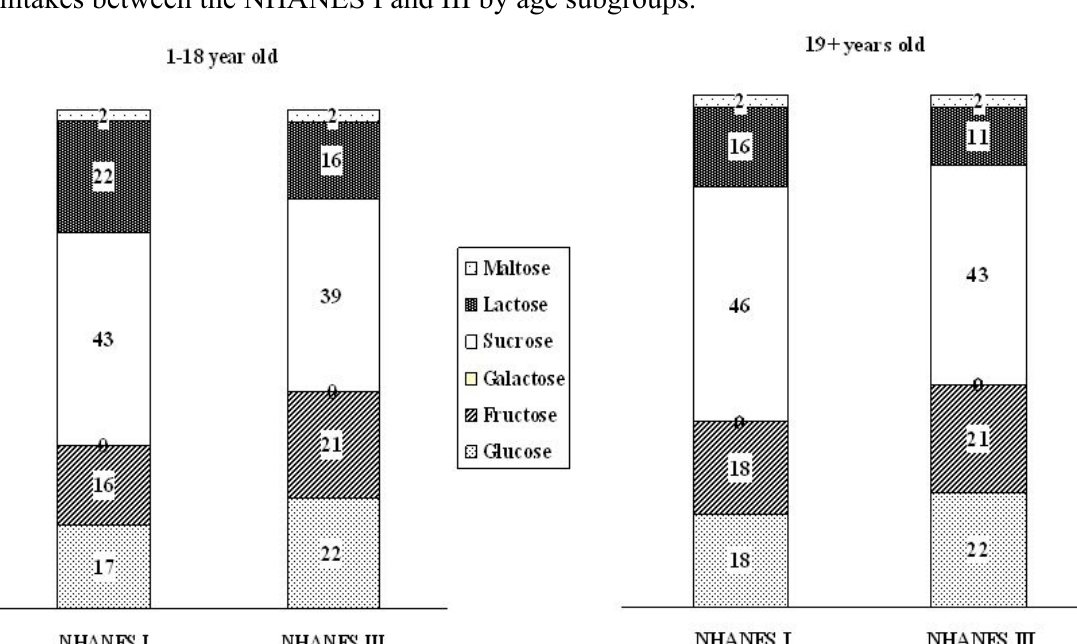
Figure 1 . Comparison of the contribution (%) of individual sugars* to the total sugar intakes between the NHANES I and III by age